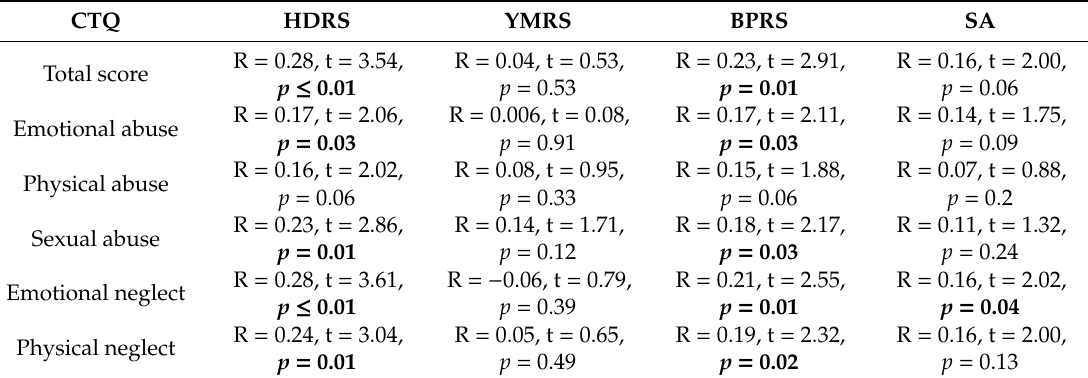
Table 4. Freedman Lane analysis to evaluate the relation between the childhood trauma questionnaire scores and clinical variables from the HDRS, YMRS, BPRS, and the suicide